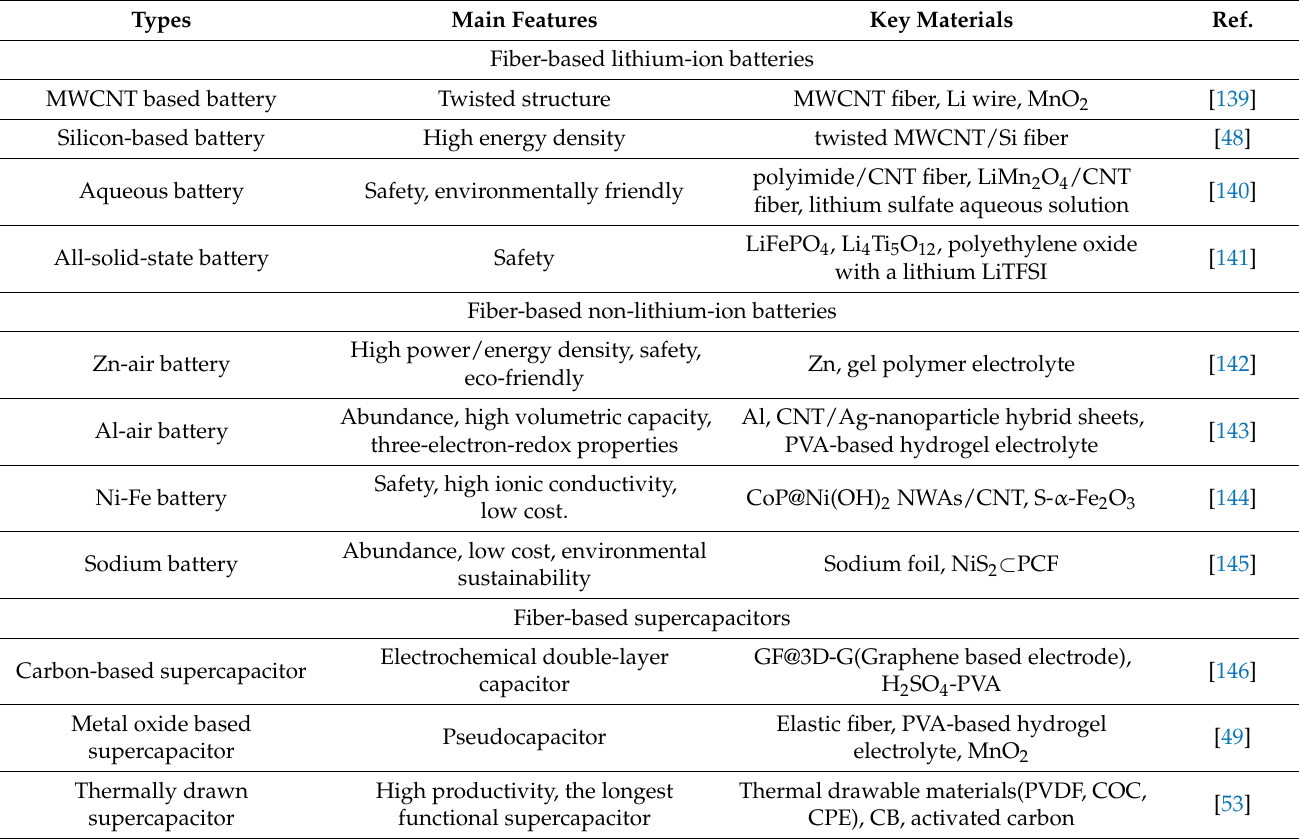
Table 3. Main features of fiber-based batteries and